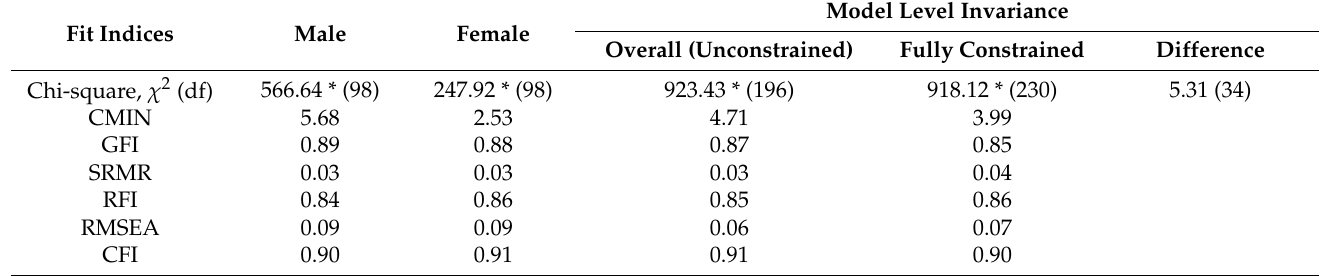
Table 5. Model Level